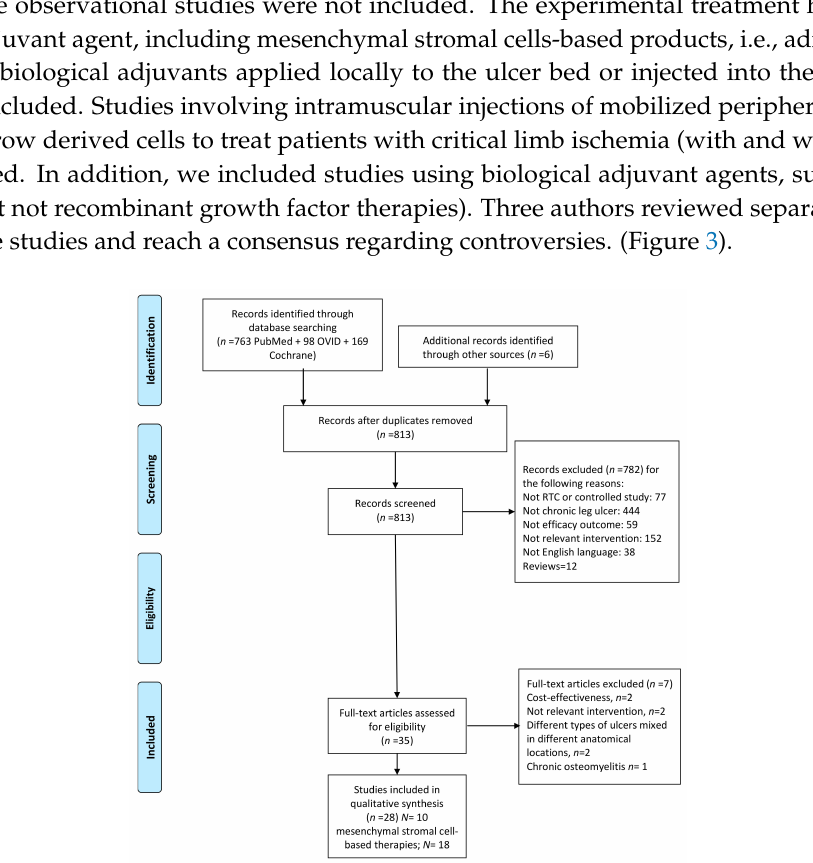
Figure 3. Flow diagram of study